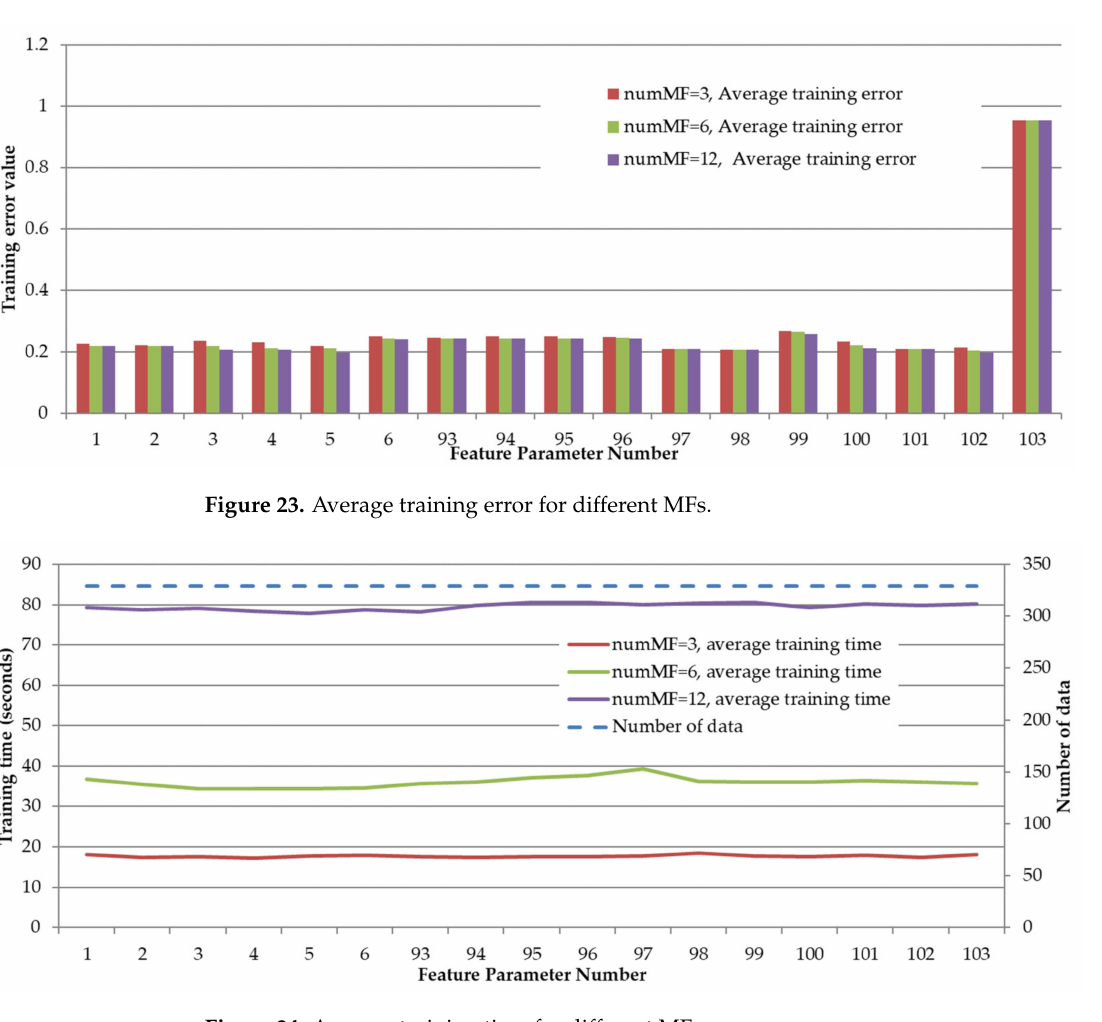
Figure 24. Average training time for different